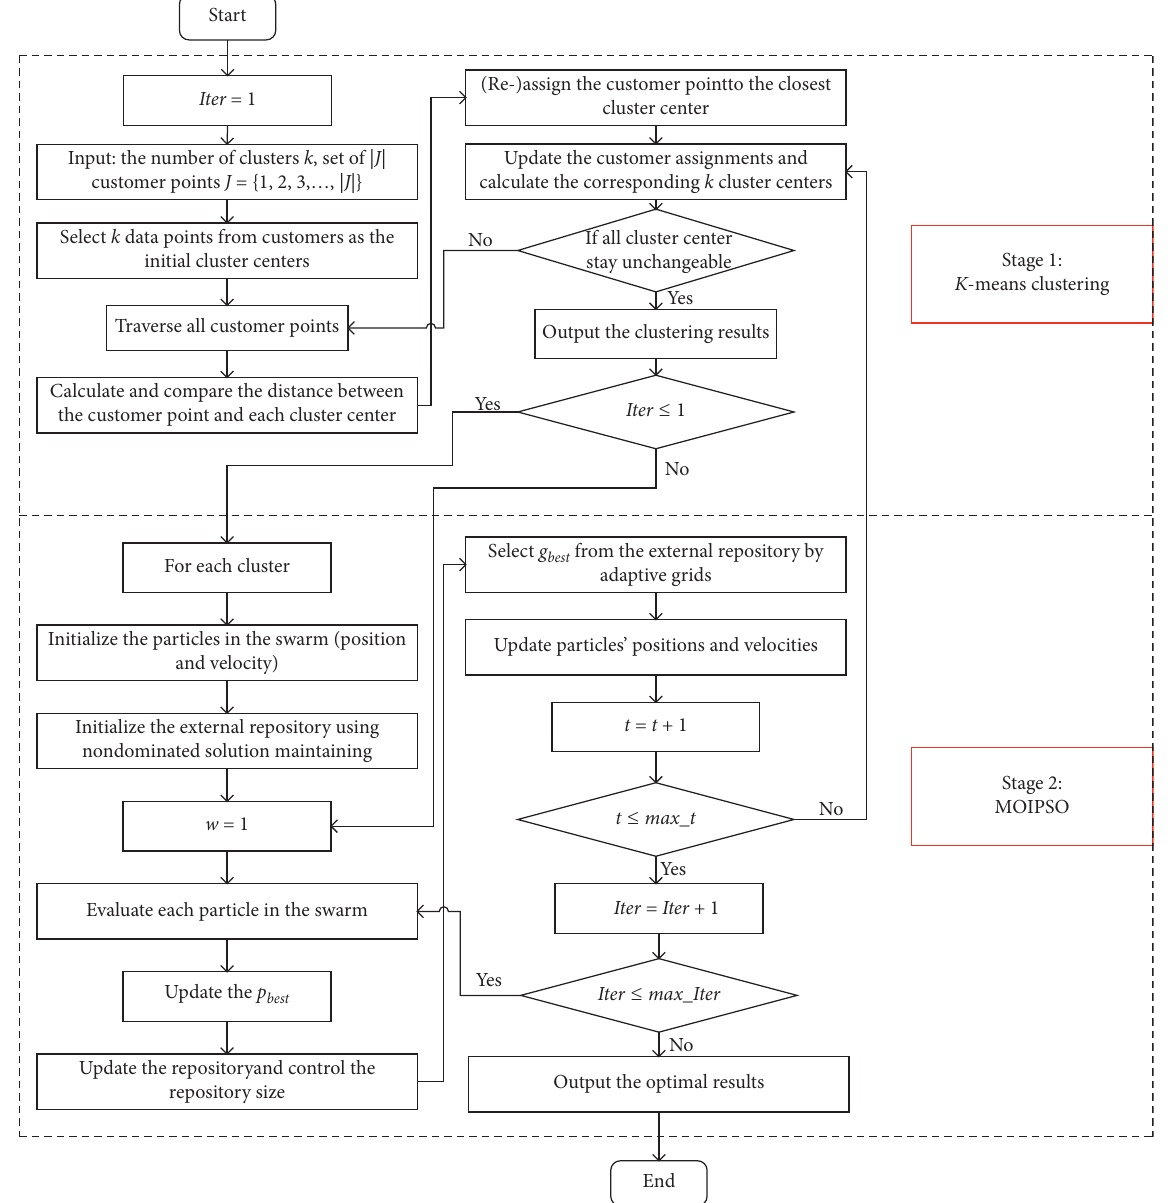
Figure 2: Flowchart of the hybrid algorithm for 2E-LRPTWTRS